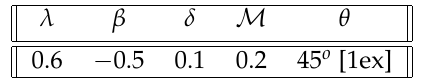
Table 1. Geometric and physical properties of the fluid.